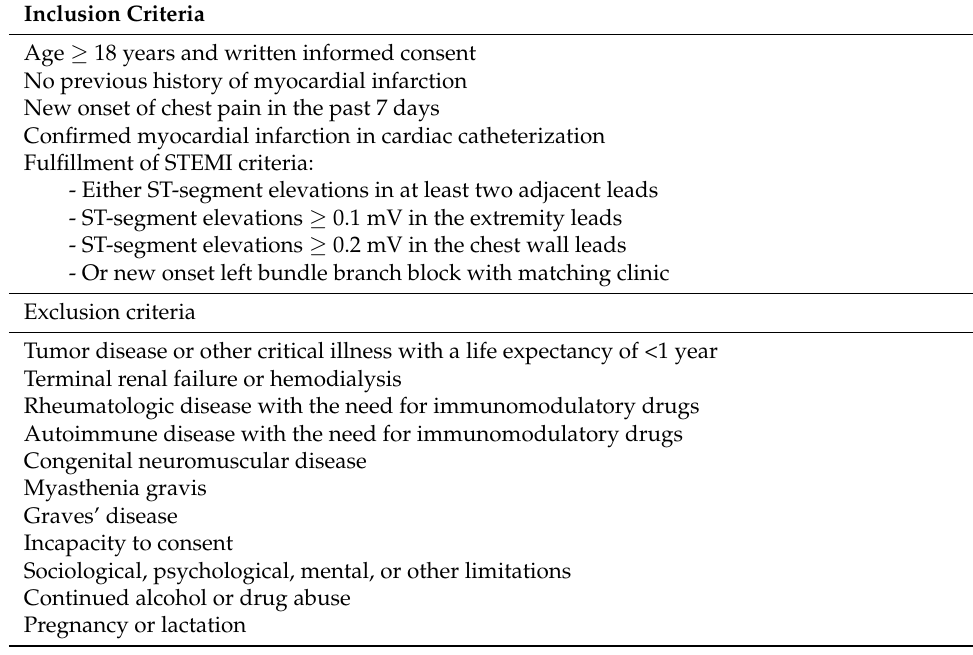
Table 4. Inclusion and exclusion criteria of the ETiCS